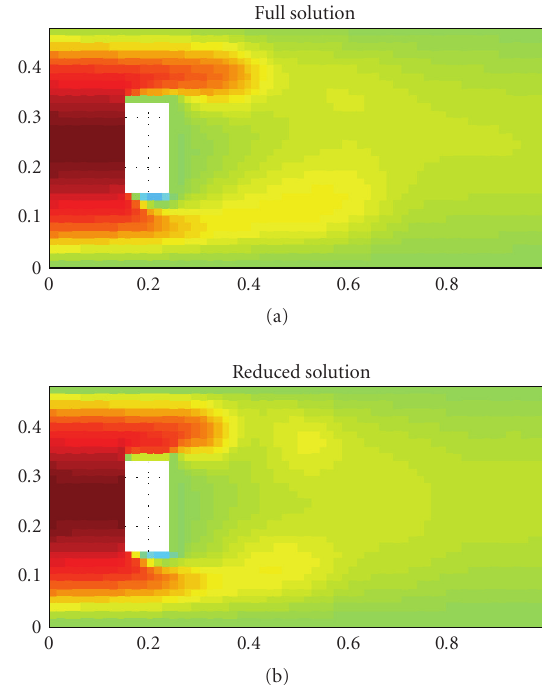
Figure 8: Full- and reduced-order models’ responses.